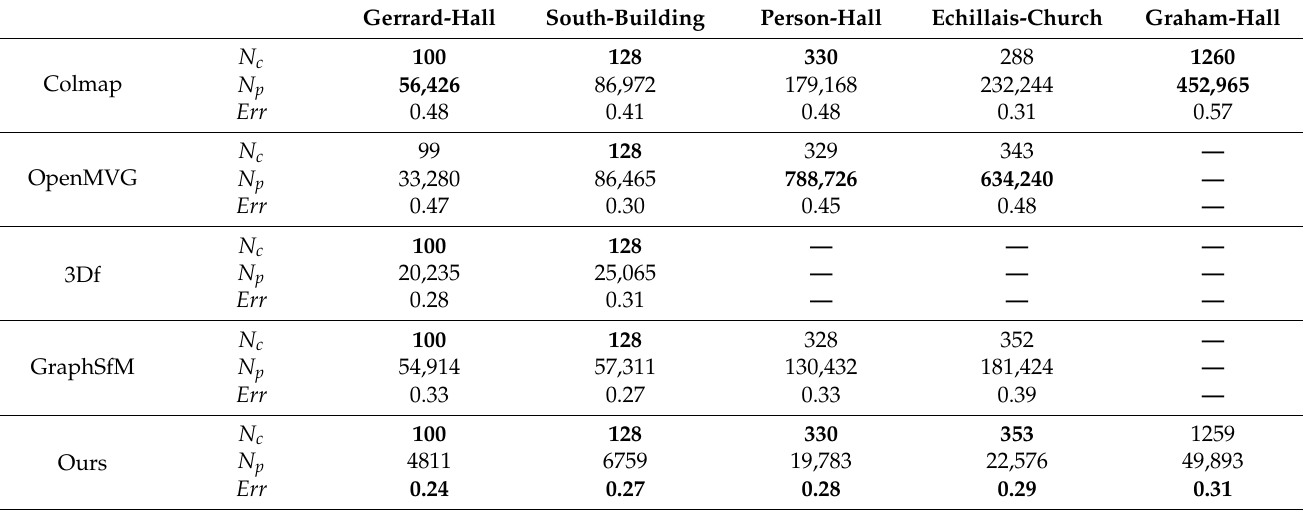
Table 5. Public dataset accuracy statistics. ( N c : number of registered images; N p : number of structure points; Err : reprojection error (MSE), in pixels; — represents reconstruction failure).